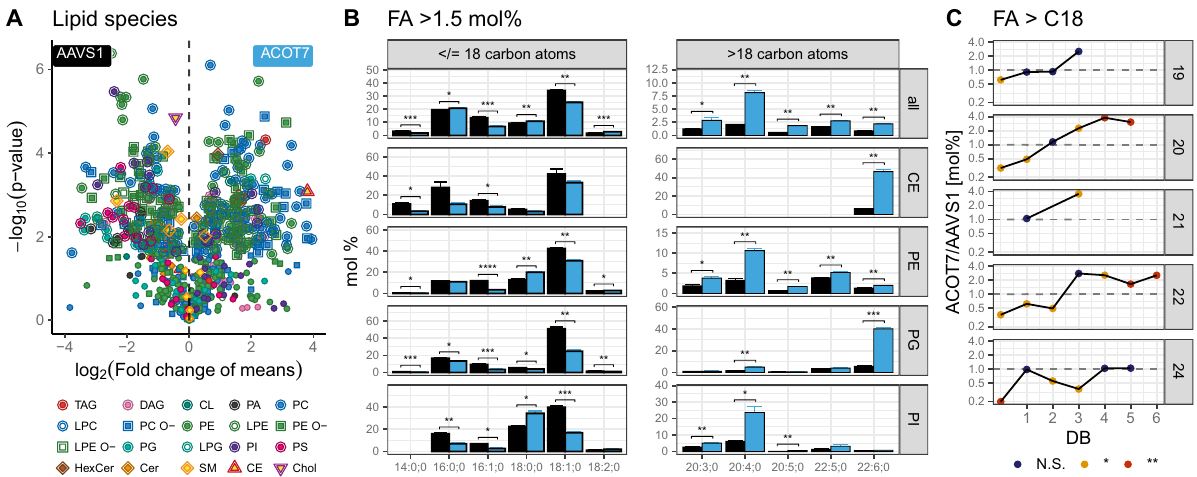
Figure 6. ACOT7 knockout: ( A ) Volcano plot: Lipid species of the ACOT7 KO cell line (n = 3) and the AAVS1 control (n = 3) were compared. P-values of t-tests without correction for multiple testing are displayed on the y-axis, fold-changes of means are shown on the x-axis. Points with additional outlines indicate lipids significant after correction for multiple testing (Benjamini–Hochberg, 358 lipid species or 54.1% of all species). The shapes and colors of points indicate the lipid class of the species. ( B ) Fatty acid profile: greater than 1.5 mol% across CE, DAG, LPC, LPE, LPE O-, LPG, PA, PC, PC O-, PE, PE O-, PG, PI, PS, TAG lipid classes and individual profiles of CE, PE, PG, PI. Means are indicated by bar plots. Error bars correspond to standard deviations. p-values have been adjusted for the total number fatty residues (n = 50) or the total number fatty residues and lipid classes (n = 240) and are encoded as follows: * for q < 0.05, ** for q < 0.01, *** for q < 0.01, **** for q < 0.0001. ( C ) Fatty acid ratios: of FAs greater than 18 carbon atoms across CE, DAG, LPC, LPE, LPE O-, LPG, PA, PC, PC O-, PE, PE O-, PG, PI, PS, TAG lipid classes. Fatty acid length in carbon atoms is shown in panels and fatty acid double bonds on the x-axis. The ratio of the means ACOT7/AAVS1 [mol%] as depicted in ( B ) is shown on the y-axis, with the corresponding p-values corrected for multiple testing encoded in color. Only lipid species were used, which had at least 2 valid measurements in each of the two cell lines (n = 662). The ACOT7 KO clone G12 is displayed, which was created by the gene trap